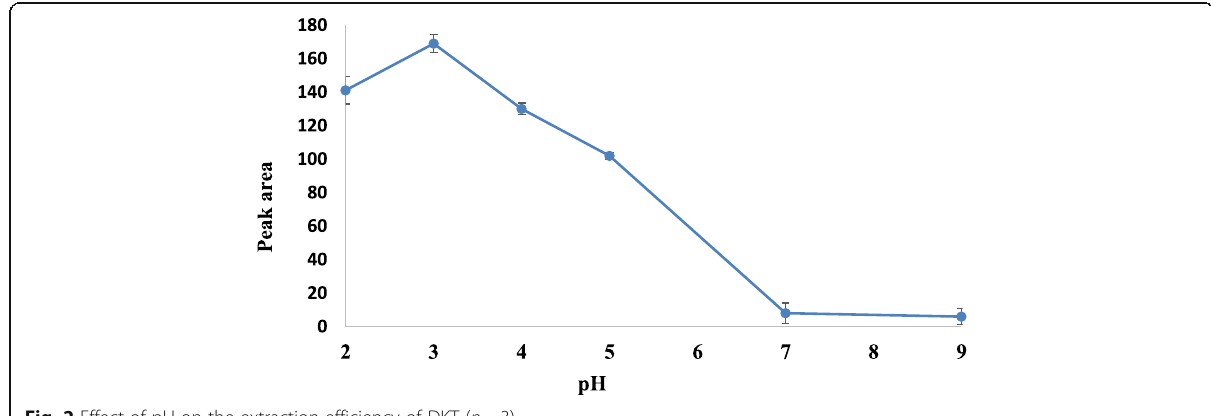
Fig. 2 Effect of pH on the extraction efficiency of DKT ( n = 3)